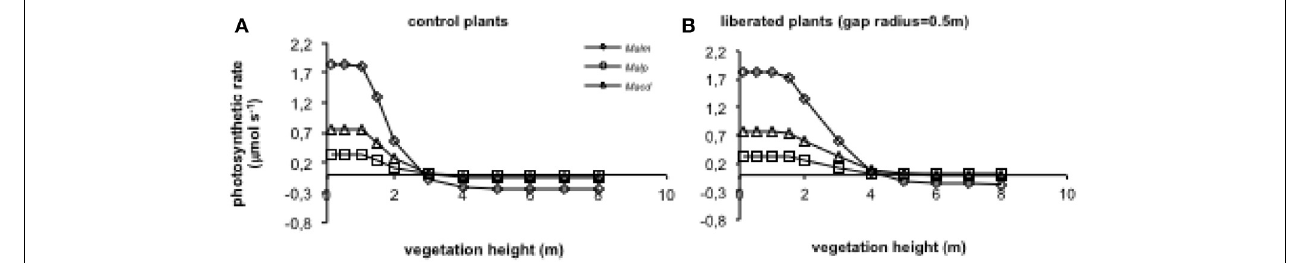
FIGURE 8 | (A,B) Model simulations of the effect of height of the surrounding vegetation on whole canopy photosynthetic rates of species in a control situation (surrounding vegetation intact) (A) and liberated plants (B) in